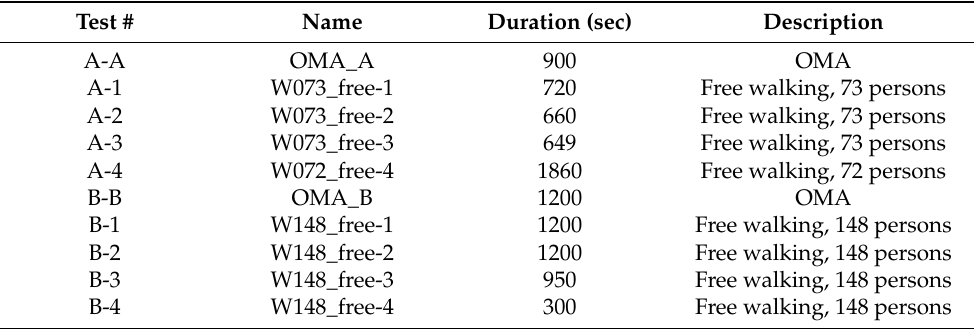
Figure 3. Top view of the Eeklo Bridge and the coordinate system [57]. Table 1. Monitoring tests of the Eeklo Bridge [57].